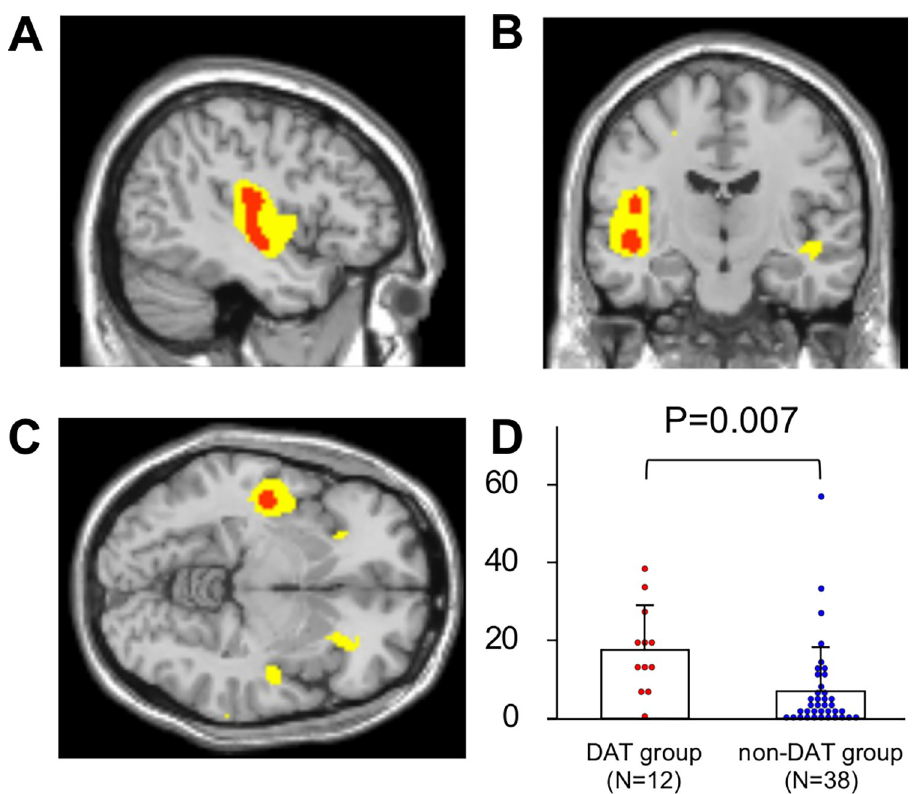
Fig 2. Lower insular perfusion in the DAT group compared with the non-DAT group. Results of the whole brain voxel-wise analysis shown in the sagittal (A), axial (B), and the coronal slices (C) (red areas, P < 0.05 with family-wise error corrections; yellow areas, P < 0.001 without corrections for multiple comparisons). In the region of interest-based analysis, decrease extent ratios were higher in the DAT group (N = 12) than in the non-DAT group (N = 38) (D). Abbreviations: DAT, delirium after transcatheter aortic valve implantation.